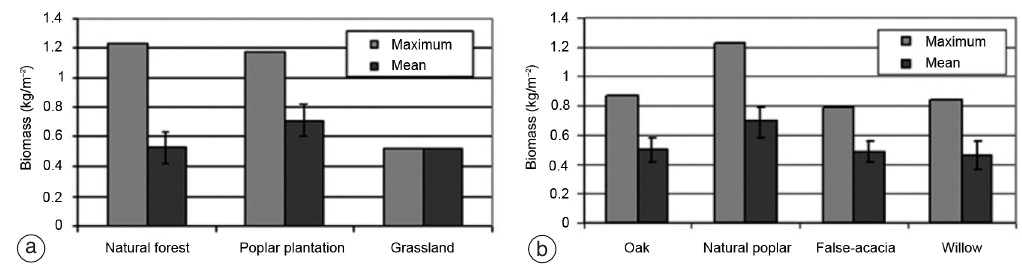
Fig. 5a,b. Mean and maximum biomass values a) for the main vegetation types (natural forest, poplar planta- tion and grassland) and b) for the different species identified within natural